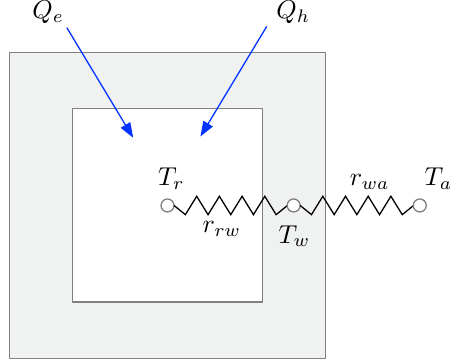
Figure 2. Lumped parameter building thermal model.